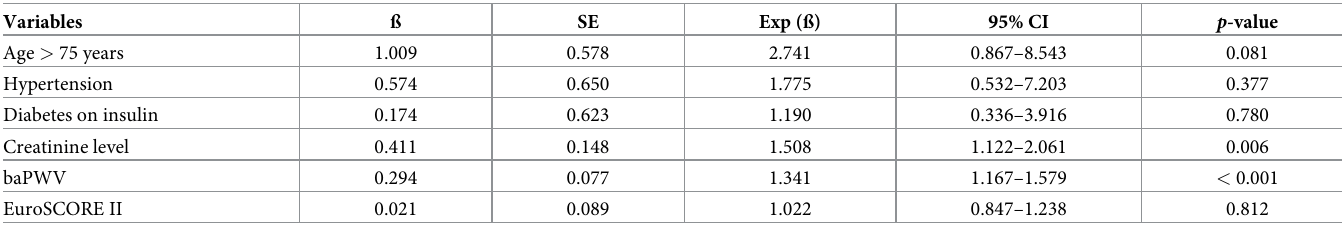
Table 3. Multivariable risk factor analysis for postoperative acute kidney injury. Variables